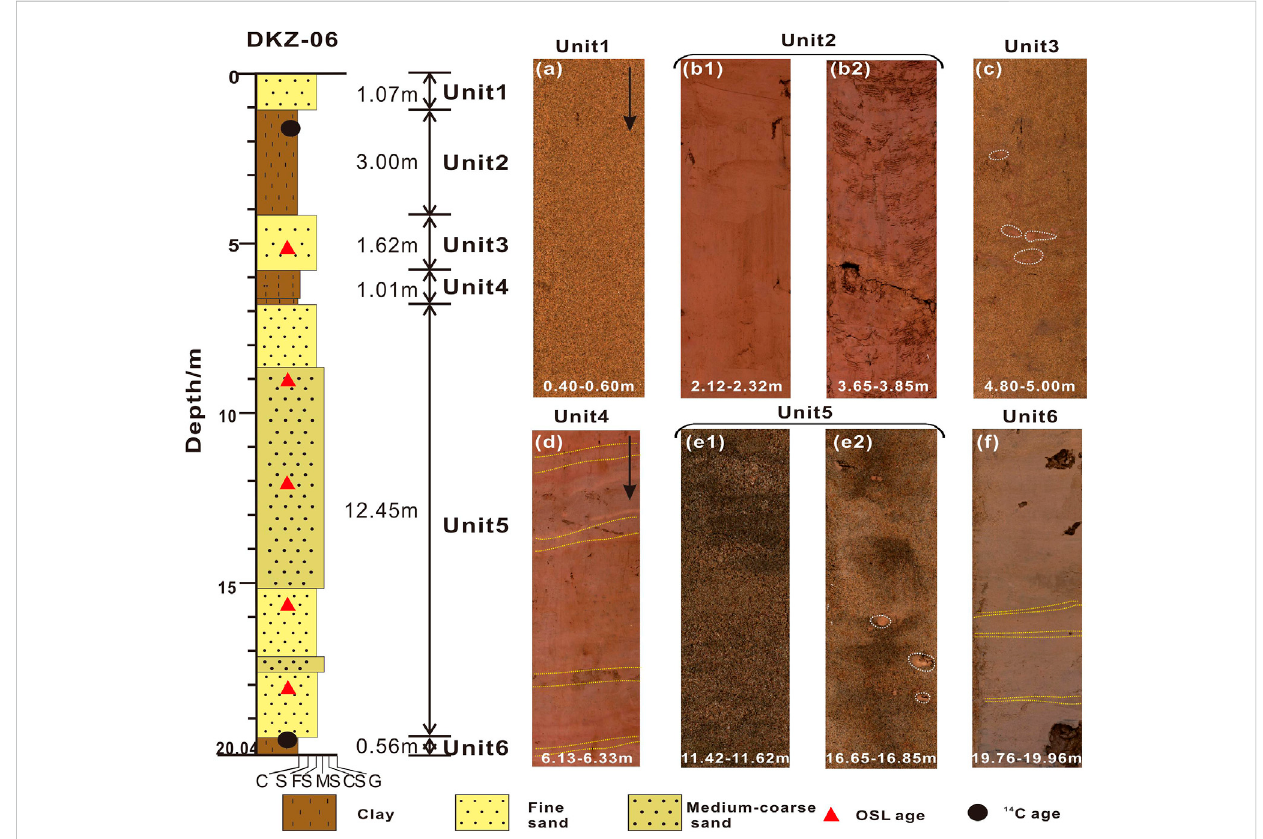
FIGURE 2 Sediment lithology and core photos. (A) Fine sandlayerinunit1. (B1and B2) Claylayers inunit2. (C) Fine sandlayersintercalated with mudballsand mudlenses(whiteovalcircle)inunit3. (D) Claylayersintercalatedwiththinsilt(yellowline)inunit4. (E1andE2) Medium-coarsesandand fi ne-sandlayers intercalated with mud balls in unit 5. (F) Clay layers intercalated with thin silt (yellow line) in unit 6. The red triangle represents optically stimulated luminescence dating samples; the black dot represents 14 C dating